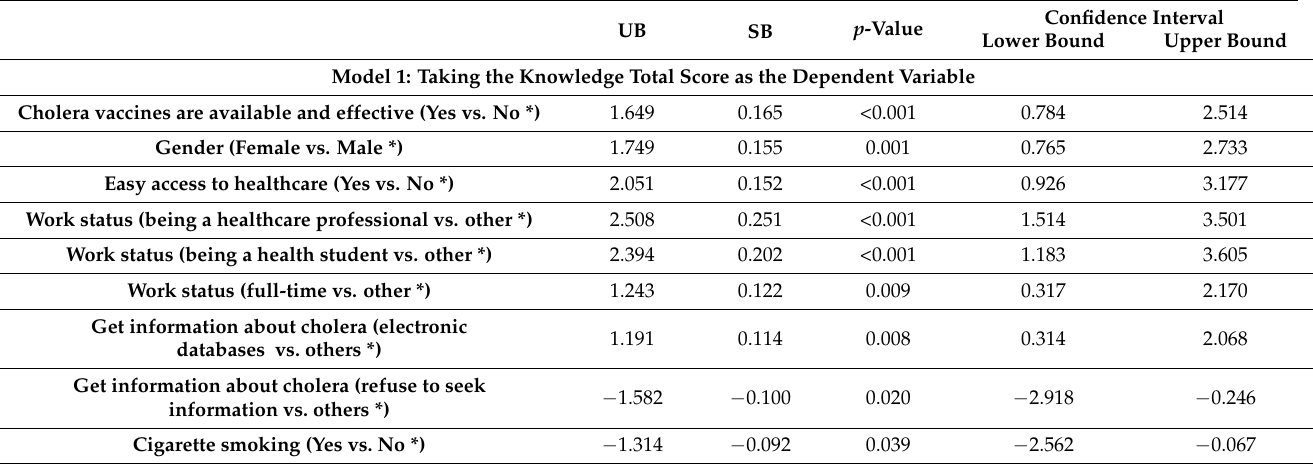
Table 7. Multivariable linear regression